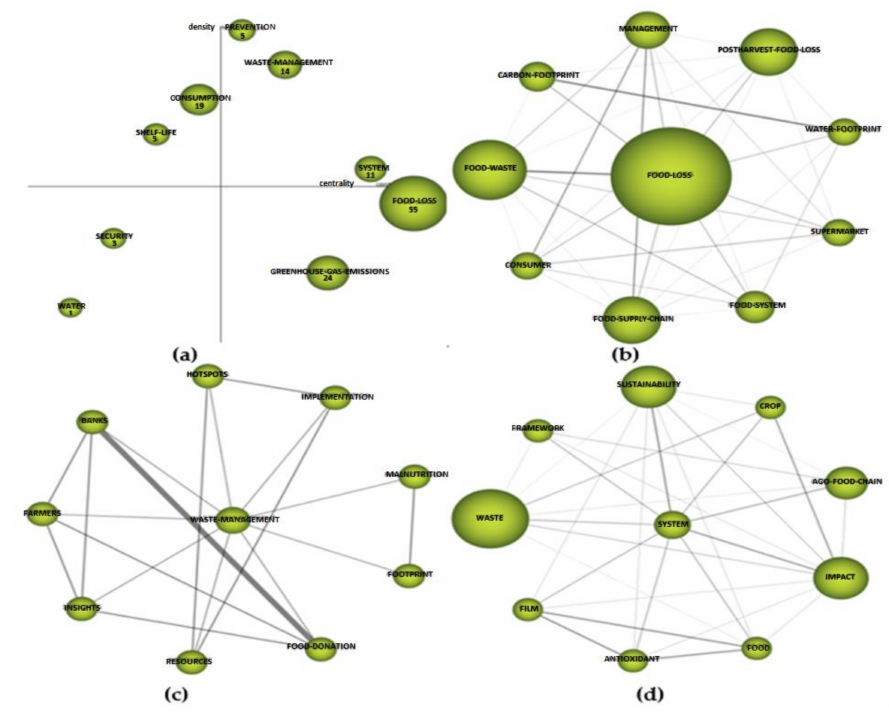
Figure 11. Strategic diagram: ( a ) and main thematic network; ( b – d ) 2016–2021 period. Table 5. Cluster